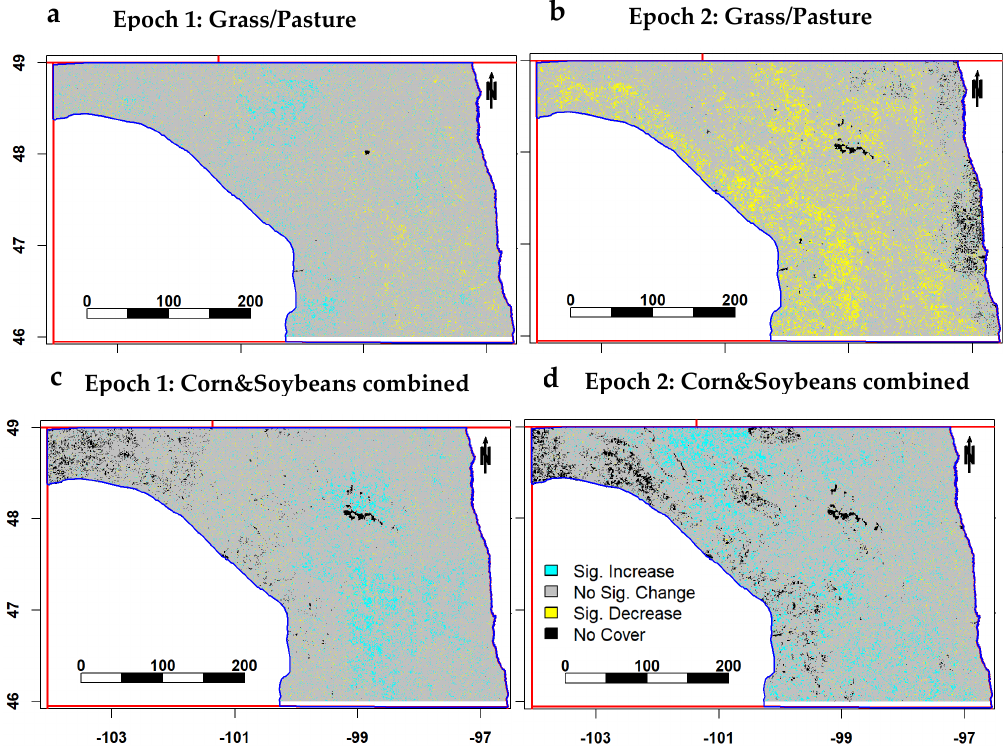
Figure 6. Mann–Kendall maps of cover classes for two epochs (E1: 1998–2007 and E2: 2008–2017): ( a ) E1 for grass/pasture; ( b ) E2 for grass/pasture; ( c ) E1 for corn & soybeans combined; ( d ) E2 for corn & soybeans combined. Each cover class is divided into four categories: significant gains (cyan; p < 0.05), non-significant change (gray; p > 0.05), significant losses (yellow; p < 0.05), with cover class absence in black. Quantitative details about these trends is presented in Figure 7. Similar maps for the remaining crop/land covers is presented in Figure S3 and Table S3.